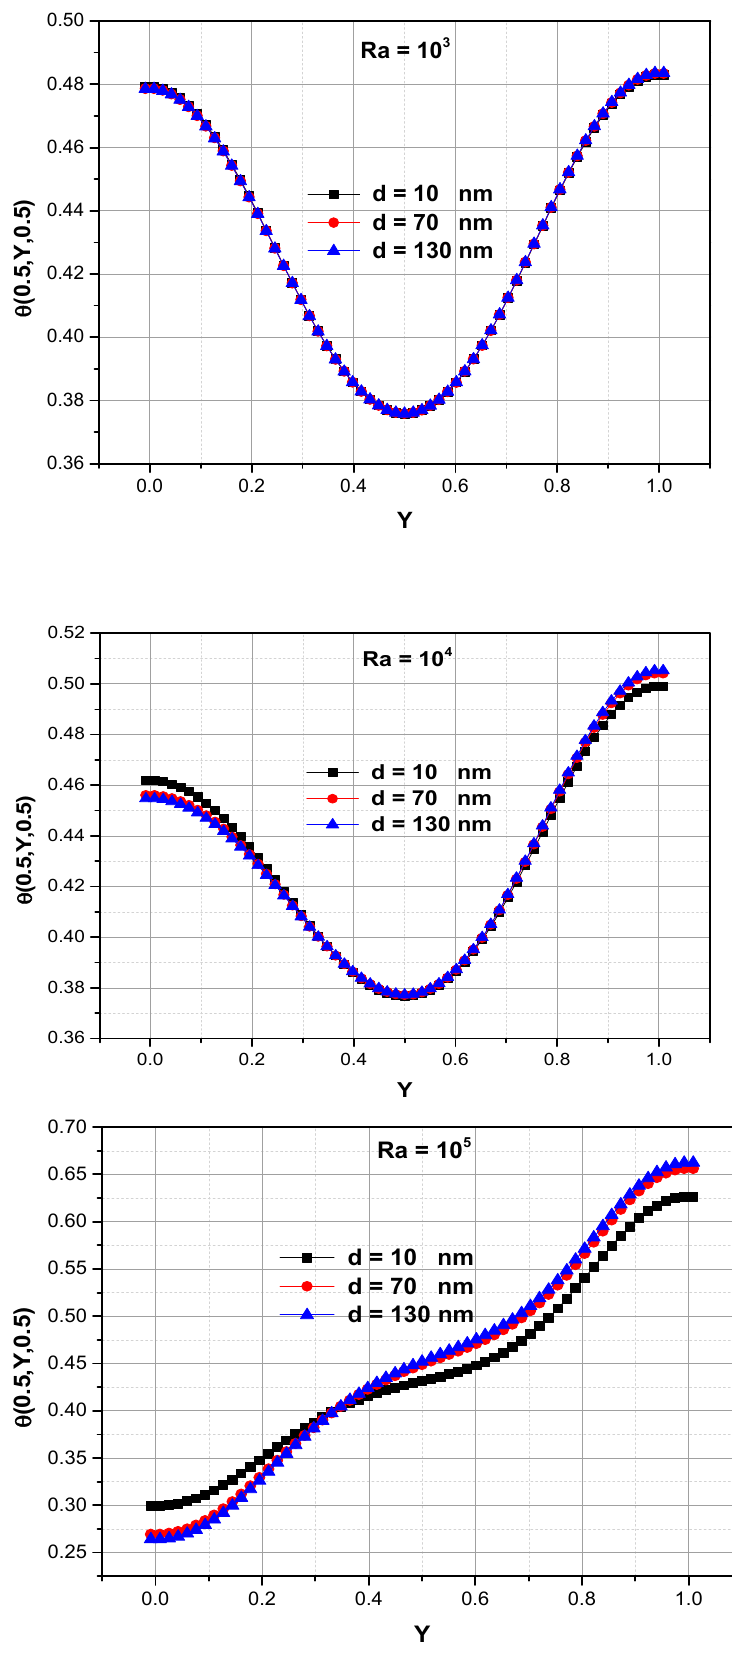
Figure 10. Variation of the temperature profiles on the Y -axis for different Rayleigh numbers and nanoparticle diameters at (Ha = 30 and φ = 0.04).